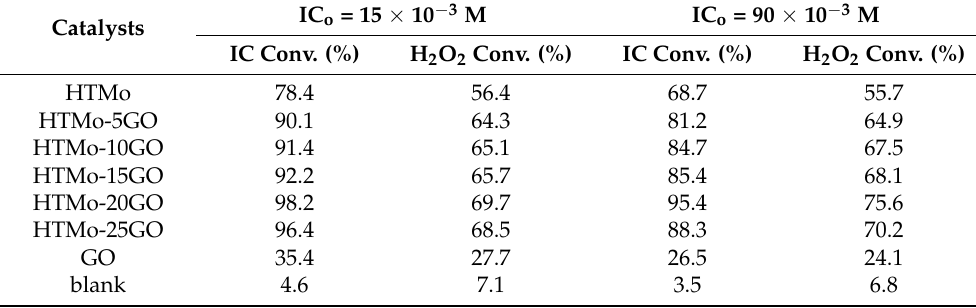
Table 6. The influence of the initial concentration of IC on the catalytic activity of